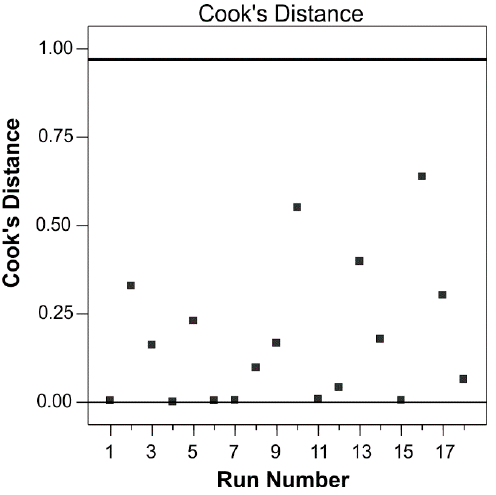
Figure 2. Cook’s distance for the reduced polynomial model.